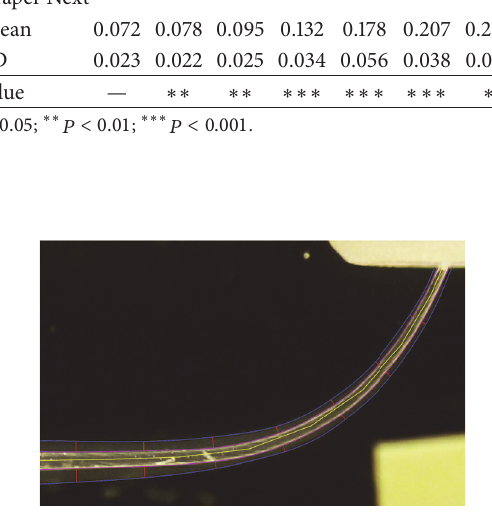
Figure 3: A perpendicular line to the segmented one was then drawn at each reference point. Afterwards, with the command “CUT,” two smaller fractions of the perpendicular lines comprised between the inner and outer limits of the canal, before and after shaping, were obtained.